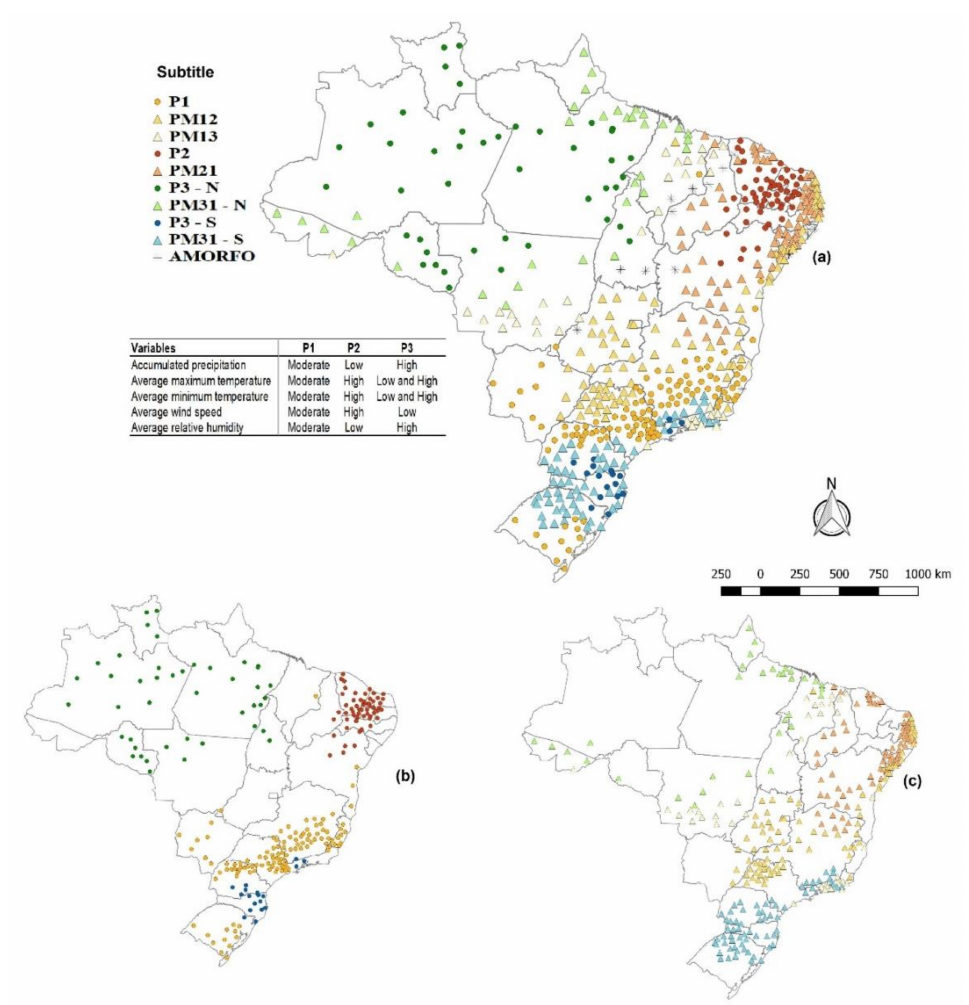
Figure 2. Map of the distribution of the microregions, according to the predominance of pure and mixed profiles: ( a ) all profiles, ( b ) pure profiles and ( c ) mixed